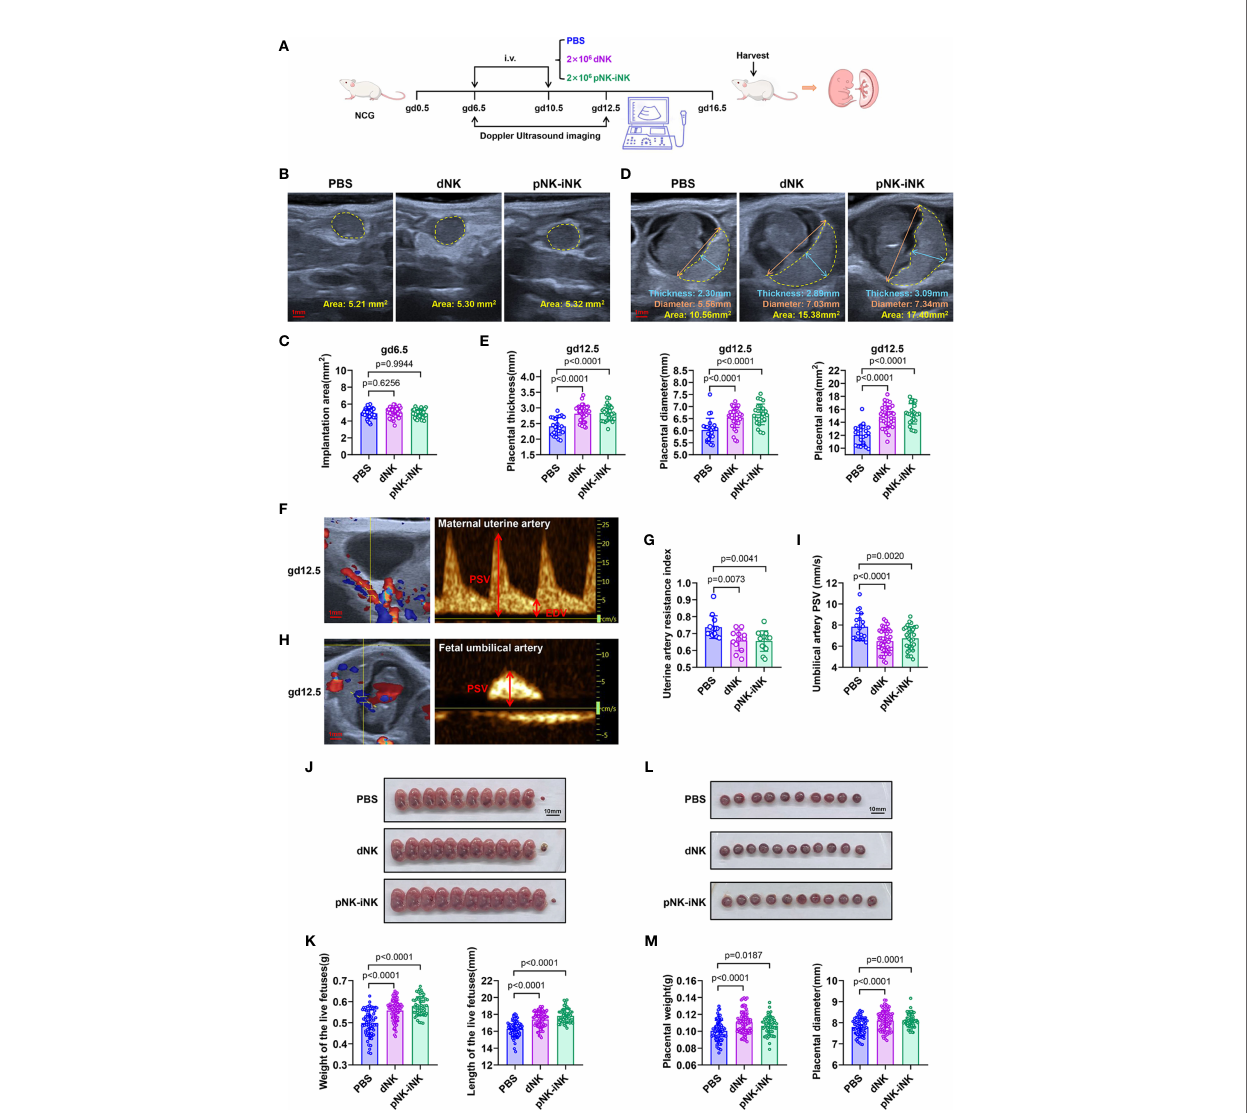
FIGURE 5 | Adoptive transferred pNK-iNK cells promote fetal growth. (A) Schematic diagram of adoptive transferring pNK-iNK cells in pregnancy mice model, n=6 pregnancy mice per group. The experiment was performed twice and the results were shown only once. (B, C) Implantation areas of pregnancy mice before being transferred cells at gd6.5. Bar, 1 mm. Representative ultrasound images from the three groups (B) and statistical calculations (C) are shown. Results are presented as individual values for each implantation and mean. (D, E) Placental measurements at gd12.5. Bar, 1 mm. (D) Representative ultrasound image of the single fetus, showing placental thickness, placental diameter, and placental area. (E) Statistical calculation of the measurements is shown. Results are presented as individual values for each placenta and mean. (F – I) Analysis of blood fl ow velocities at gd12.5. Bar, 1 mm. Representative CF (left) and PW (right) doppler images showing PSV and EDV of UA (F) and UmA (H) . (G) Statistical calculation of UA resistance index (2 experimental repeats were combined). (I) Statistical calculation of UmA peak systolic velocities. (J – M) The pregnancy outcome of adoptive transferring NK cells in mice. Bar, 10 mm. (J) Representative pictures of fetuses from NK-cells transferred mice and control mice (PBS transferred) at gd16.5. (K) Statistics were calculated by the weight and length of the live fetus in different groups. (L) Representative pictures of the placenta correspond to the fetus in (J) . (M) Statistics were calculated by the weight and diameter of the placenta. Data represent means±SD. Data were analyzed by one-way ANOVA (C, E, G, I, K, M)